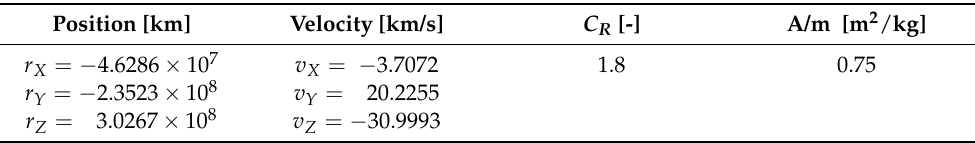
Table 1. Initial conditions for the propagation of the ’Oumuamua, taking 1 June 2017 at 00:00 TDB as the starting date [31] (Courtesy NASA/JPL-Caltech), the radiation pressure coefficient and the area-to-mass ratio.